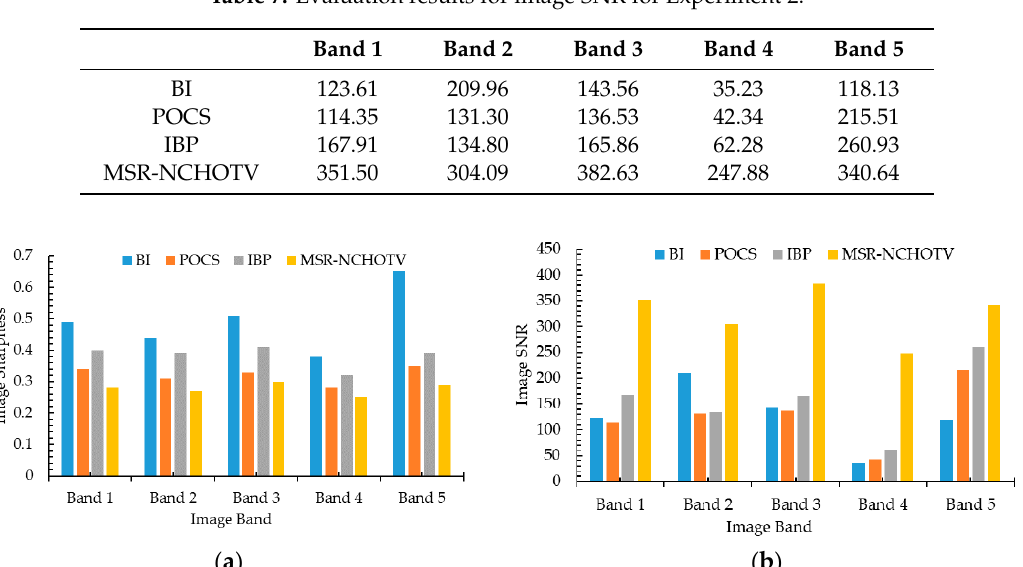
Figure 9. Image sharpness (a) and SNR (b) for Experiment 2.